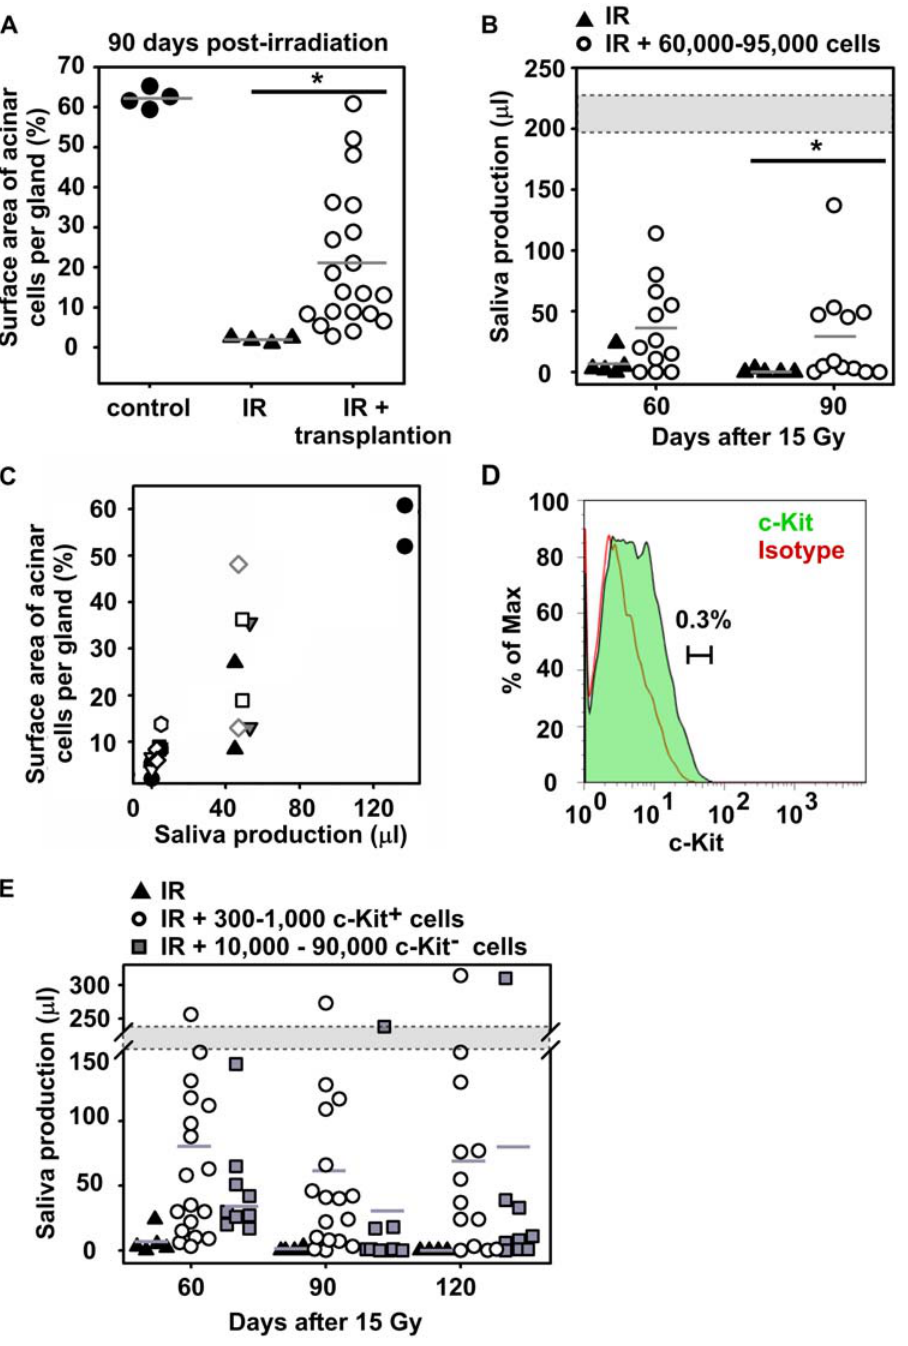
Figure 6. Restored organ function by transplanted progenitor/stem cells. (A) Quantifying the surface area occupied by acinar cells at 90 days post-irradiation revealed that transplanted glands contain significantly more acinar cells ( # ) compared to irradiated glands ( m ). Saliva production measured on 90 days post-irradiation (B) was significantly higher enhanced in transplanted mice ( # ) compared to irradiated mice ( m ). Gland function was restored in successfully transplanted mice to 23% up to 70% of normal production (gray area). (C) Saliva production correlated strongly with acinar cell restoration. Each symbol indicates a unique animal, at each time point two glands per animal were evaluated. (D) After 3 days in culture, the c-Kit brightest cells were FACS purified based on the indicated gate. (E) Injection of c-Kit + cells (300 to 1,000 cells per gland) restored gland function in 9 out of 13 recipients until 120 days post-irradiation, whereas 3/9 responded when 10,000–90,000 c-Kit 2 cells were transplanted.